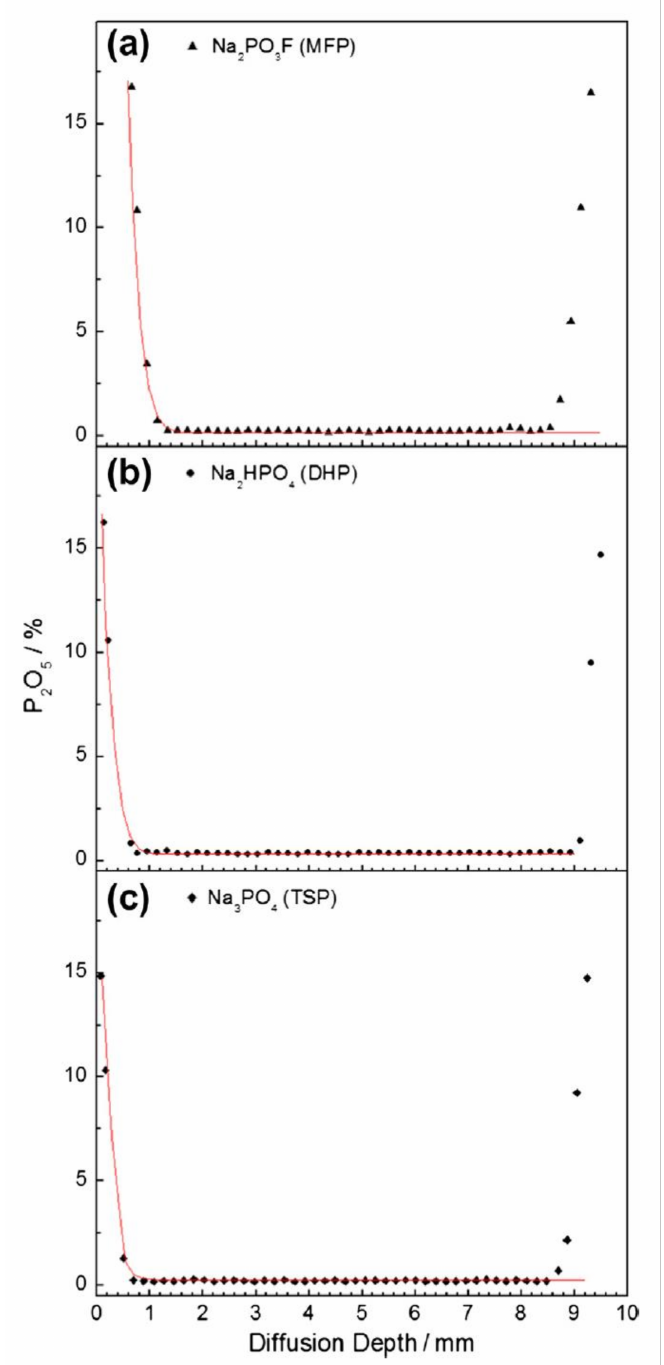
Figure 12. Content of P 2 O 5 versus penetration depth in the presence of migrating corrosion inhibitor (MCI): ( a ) MFP, ( b ) DHP and ( c ) TSP [43]. Reproduced with permission from Bastidas, D.M. et al., Cem. Conc. Comp.; published by Elsevier,